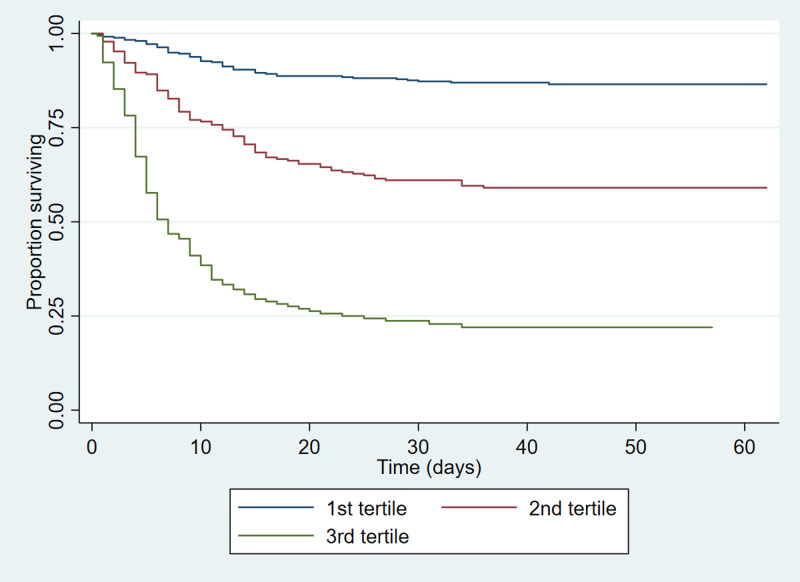
Kaplan–Meier plot of time to death split into tertiles by predicted risk from the multivariable model.